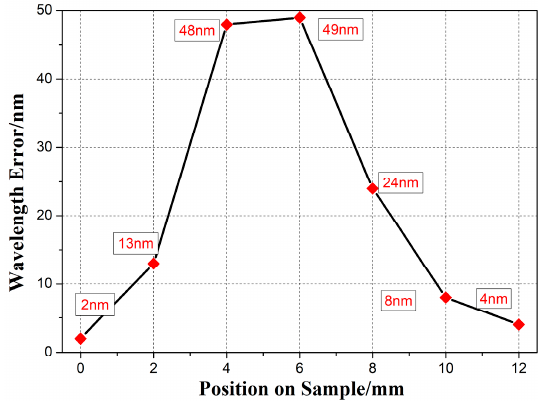
Figure 5. Film thickness mismatching error in sampling points.